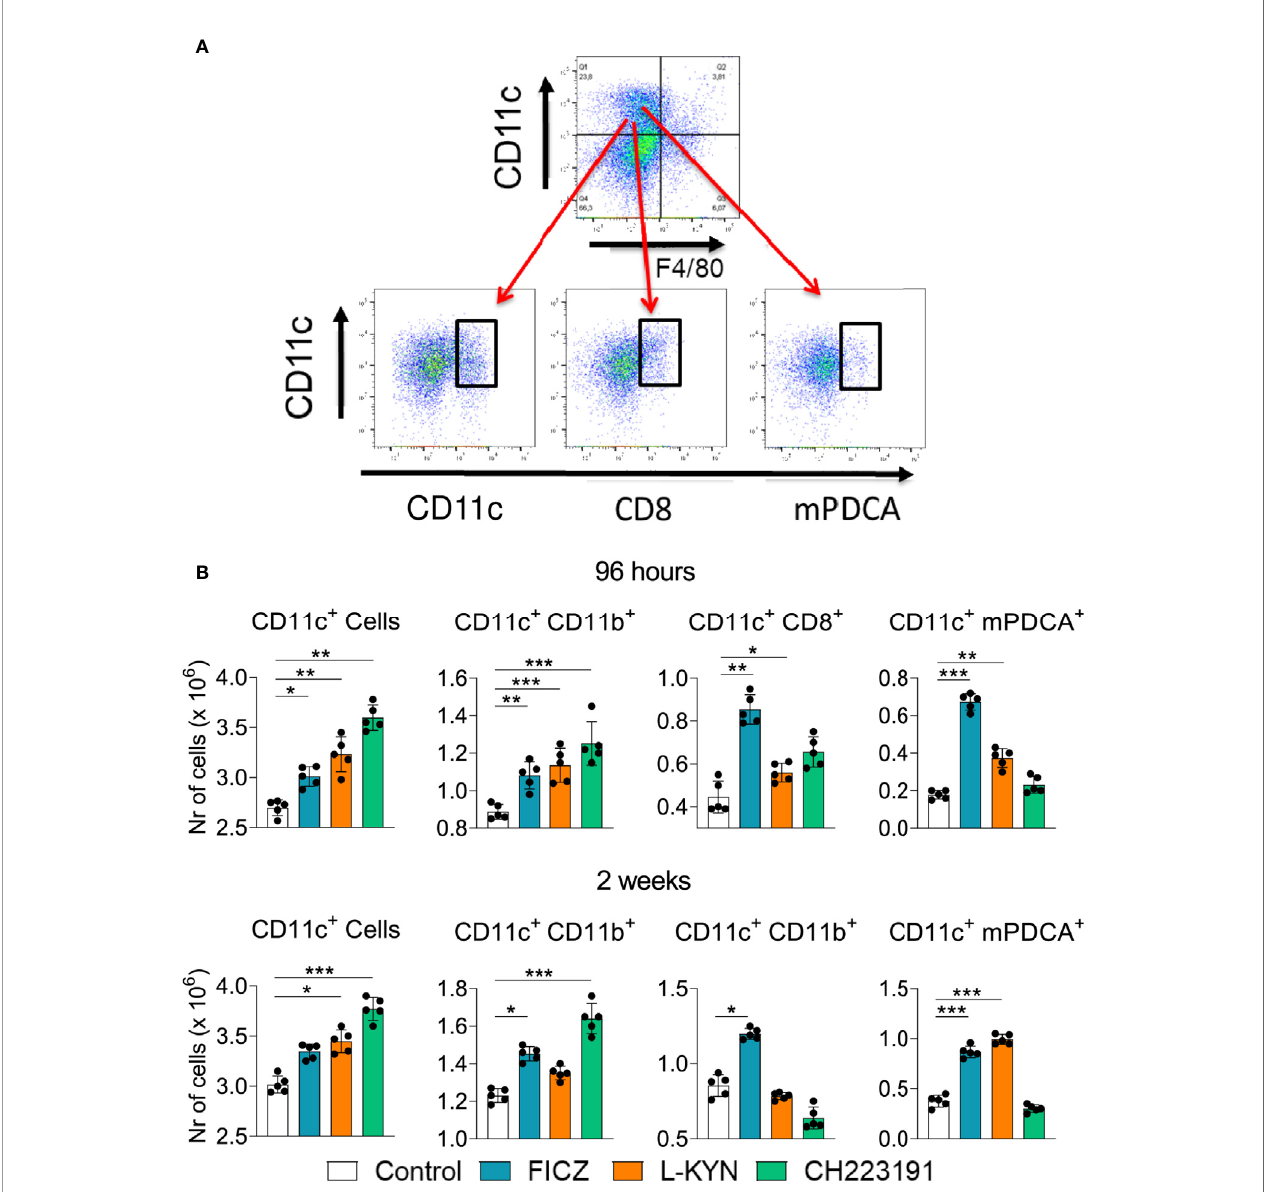
FIGURE 4 | Treatment with AhR agonists (FICZ and L-Kyn) and antagonist (CH223191) increases the migration of dendritic cells (DCs) to the lungs of P. brasiliensis infected mice. C57BL/6 mice (n = 5) were infected with 1 x 10 6 P. brasiliensis yeasts and treated by route i,p. on alternate days with FICZ, L-Kyn, or CH223191 as previously described. Control mice were treated with PBS. The animals were sacri fi ced 2 weeks after infection, their lungs removed, macerated and the number total CD11c+, myeloid (CD11c+CD11b +), lymphoid (CD11c+CD8+), and plasmacytoid (CD11c+mPDCA+) dendritic cells analyzed by fl ow cytometry. (A) Gate strategy to de fi ne DCs subsets. (B) Number of total pulmonary CD11c+ cells and DCs subsets observed 2 weeks after infection. The experiment was repeated twice, and data are expressed as M ± SD. P values < 0.05 were considered signi fi cant (* p < 0.05; ** p < 0.005 and *** p <